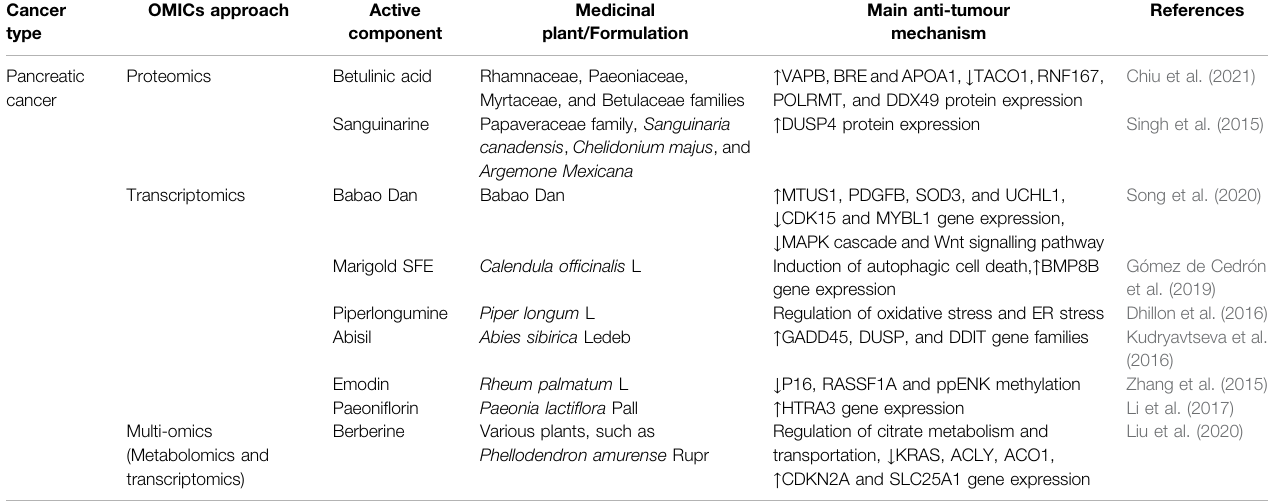
TABLE 4 | The applications of OMICS on medicinal plants in pancreatic